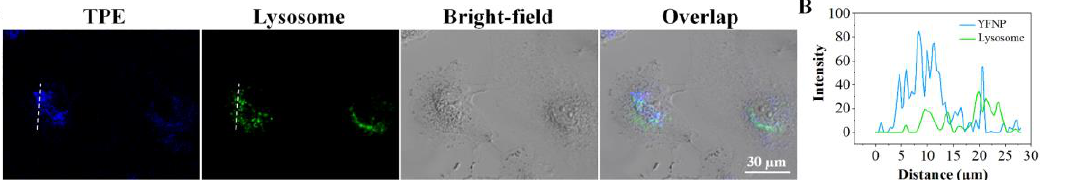
Figure 8. ( A ) The confocal fluorescence images of MCF-7 cells incubated with the YFNP for 6 h and then further incubated with 1 μM Lysotracker Green (30 min). ( B ) The intensity profile of regions of interest (the dotted lines in ( A )) cross the cells.